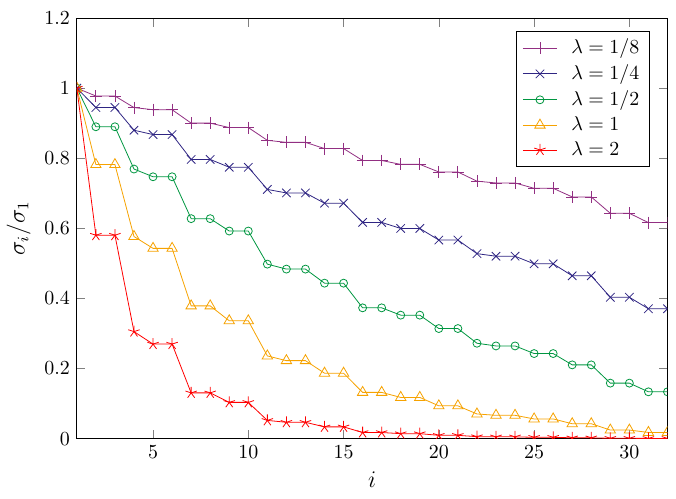
Figure 7 . The singular values σ i /σ 1 ( i = 1 , 2 , · · · , 32 ) of the fundamental tensor normalized by the largest one σ 1 are plotted in the descending order for the SU (3) gauge theory with various values of the coupling